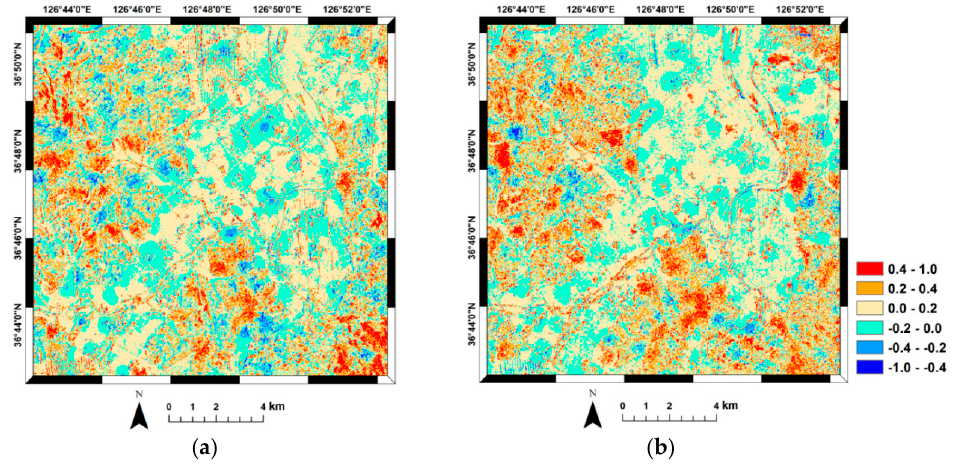
Figure 9. Difference maps of estimated classification accuracy probability: ( a ) fusion-Radsarsat-1; and ( b ) fusion-ENVISAT ASAR.